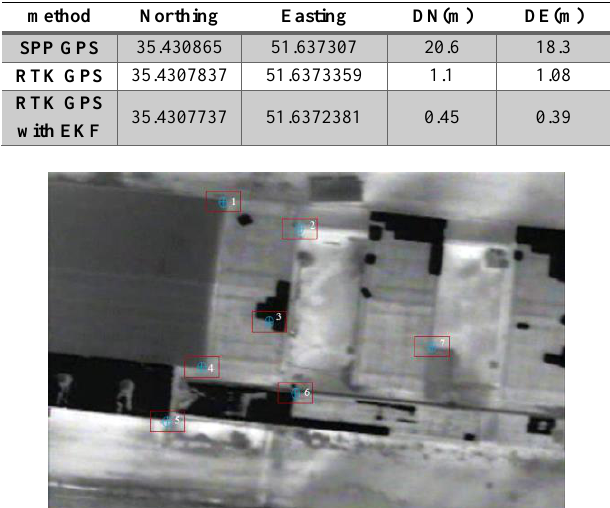
Figure 7: Targets extracted for tracking and geolocation in first frame